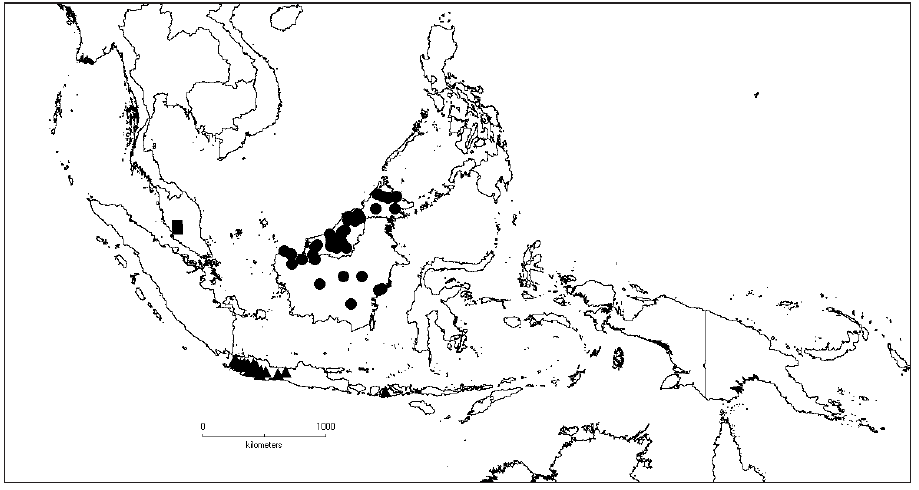
Map 24. Distribution of D. pubescens ( ● ), D. rectandra ( ■ ) and D. vacillans ( ▲